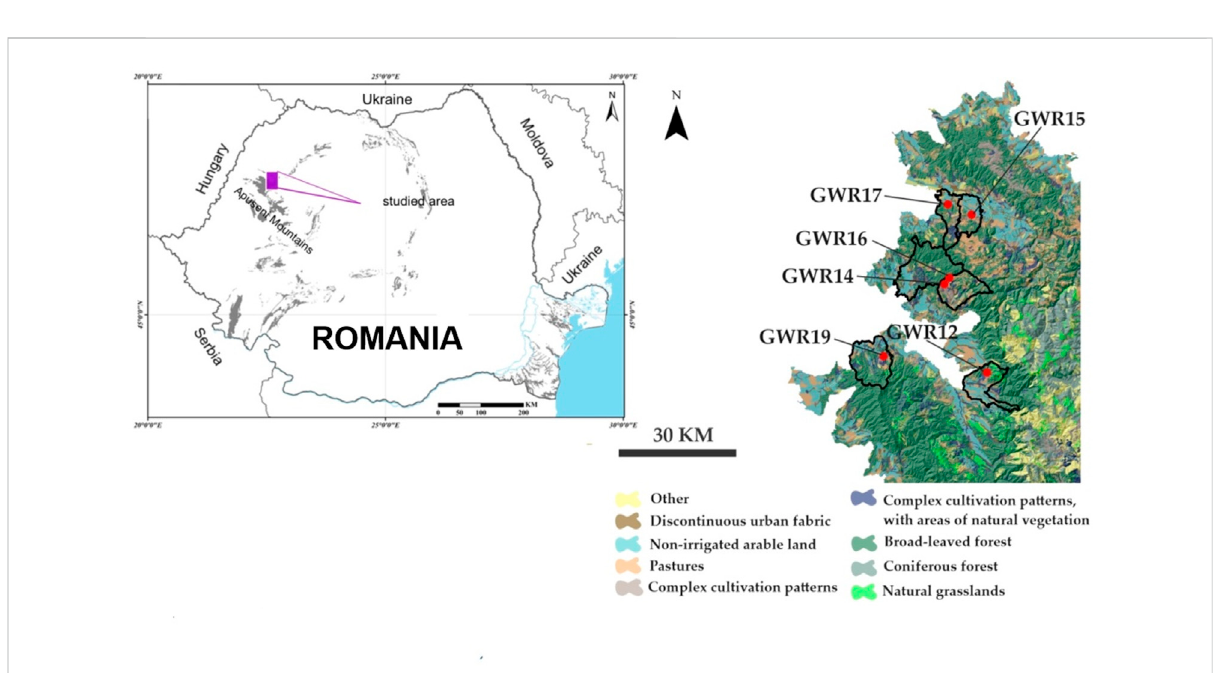
FIGURE 1 Location of the study area in Romania and a detailed map of the study area presenting the main topographic features and land